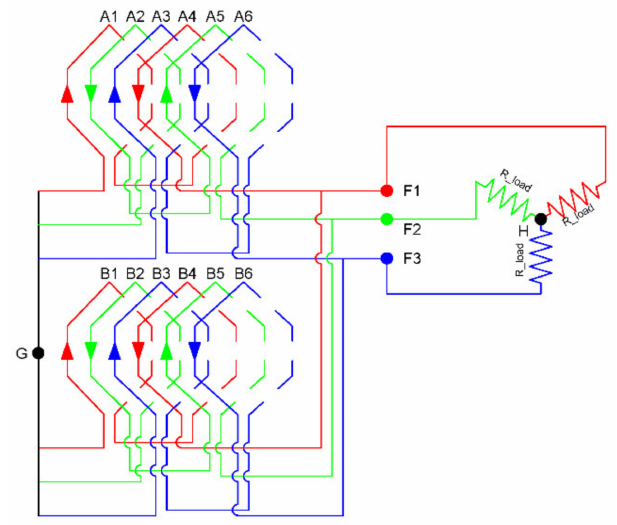
Figure 10. Connection scheme for the load